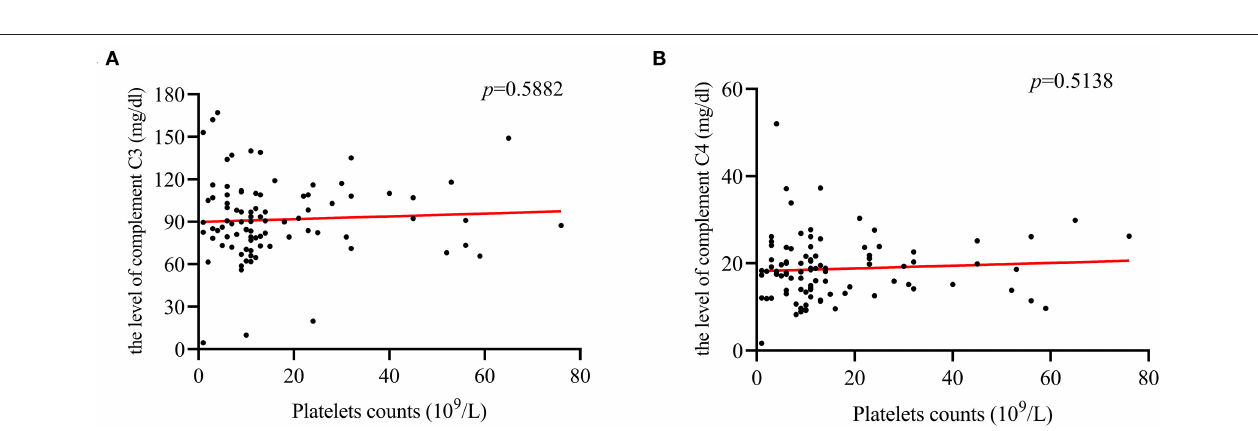
FIGURE 5 | The correlation between PLT counts and complement C3, and C4 levels. (A,B) PLT counts were not correlated with the level of complement C3 ( r = 0.09; p = 0.5882), or C4 ( r = 0.094; p = 0.5138).